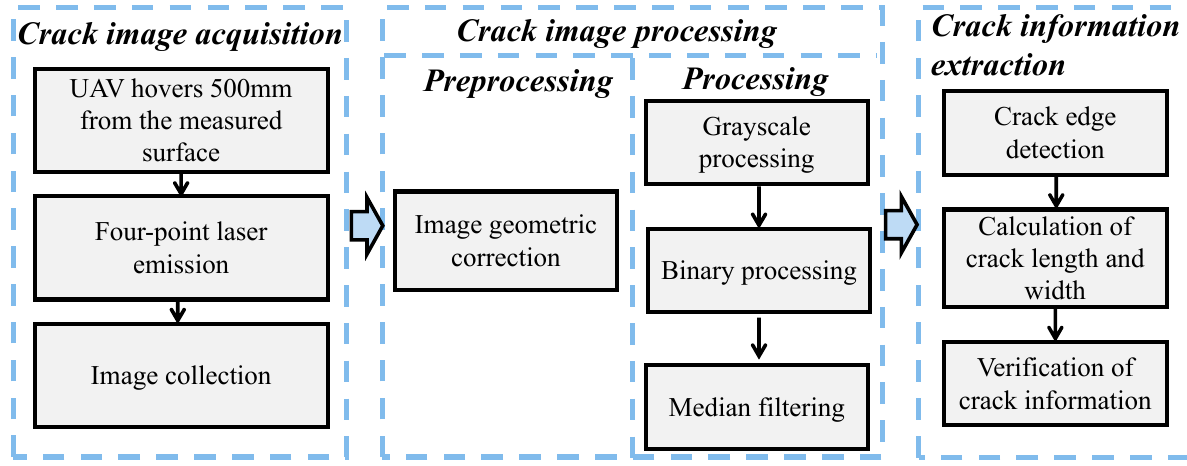
Figure 3. Workflow of the crack identification system.